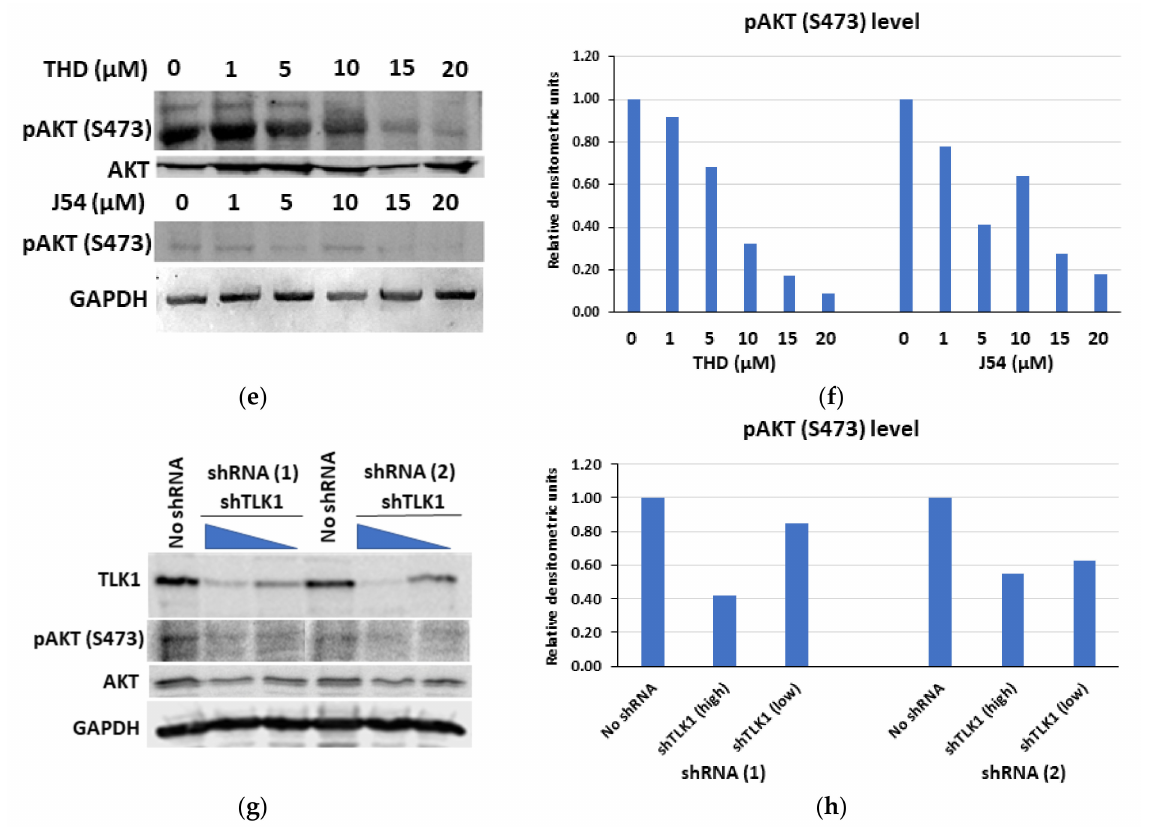
Figure 3. TLK1>AKTIP axis regulates activating AKT phosphorylations. ( a ) Incubation of LNCaP cell with charcoal-stripped serum (CSS), which elevates the expression of TLK1B, elevates the phosphorylation of AKT at T308 and S473, and this is suppressed with the TLK1 inhibitor Thioridazine (THD). Depletion of AKTIP largely suppresses AKT phosphorylation in both FCS and CSS conditions. ( c ) Depletion of AKTIP and addition of THD synergistically suppresses pAKT (S473) in both HEK 293 and LNCaP cells. ( e ) Treatment of LNCaP cells with two different inhibitors of TLK1 (THD or J54) results in dose-dependent loss of pAKT (S473). ( g ) Depletion of TLK1 with shRNA results in reduction of pAKT (S473). ( b , d , f , h ) Quantitation of the respective